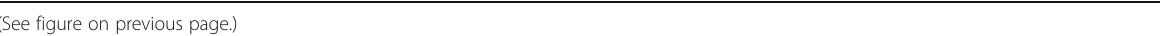
turbed evaluation of the microscopic anatomy. The critical point drying for μ CT-imaging results in rela- tively large, low-contrast, air-filled spaces around the midgut